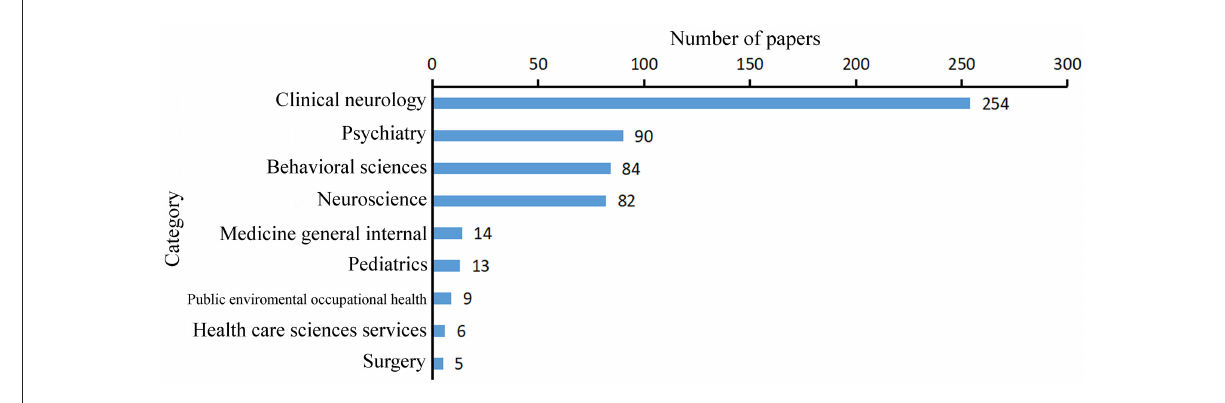
FIGURE2 WoS categories with five or more papers related to COVID-19 and epilepsy.